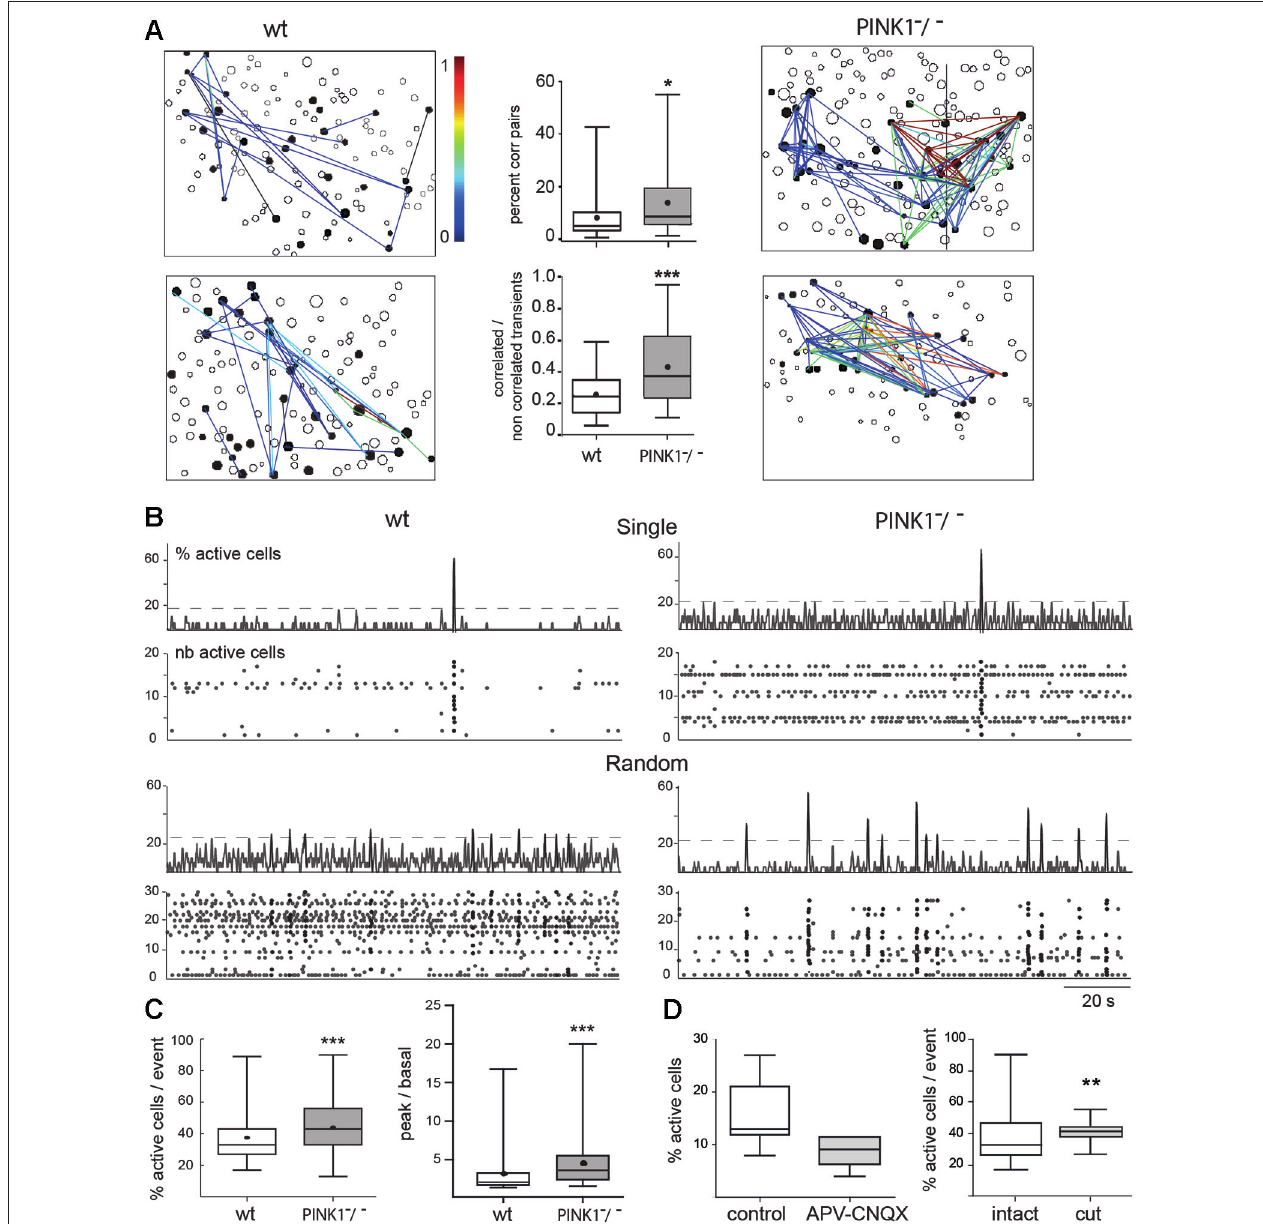
active cell pair. (B) Representative histograms (top traces, % active cells) and raster plots (bottom traces, number of active cells) of the population dynamics after onset detection in four different M1 networks in slices from P14–P16 wt (left column) and PINK1 − / − (right column) mice. The proportion of fields with singly or randomly distributed network events was for wt: 10–90%, n = 30; and for PINK1 − / − : 20–80%, n = 39. Randomly distributed network events had a similar frequency in wt (0.034 ± 0.016 Hz, n = 27 fields) as in PINK1 − / − (0.03 ± 0.02 Hz, n = 30 fields) M1 networks ( P = 0.9). (C) Percentage of active cells involved in network events (% active cells/ network event) (left) and ratio of the percentage of active cells inside (peak) and outside (basal) network events in wt ( n = 30) and PINK1 − / − ( n = 39) M1 fields that displayed single or random network events (right). (D) Percentage of active cells in wt M1 before (control) and during application of APV and CNQX (left) and percentage of active cells involved in network events before (intact) and after cutting (cut) the slices between cortex and